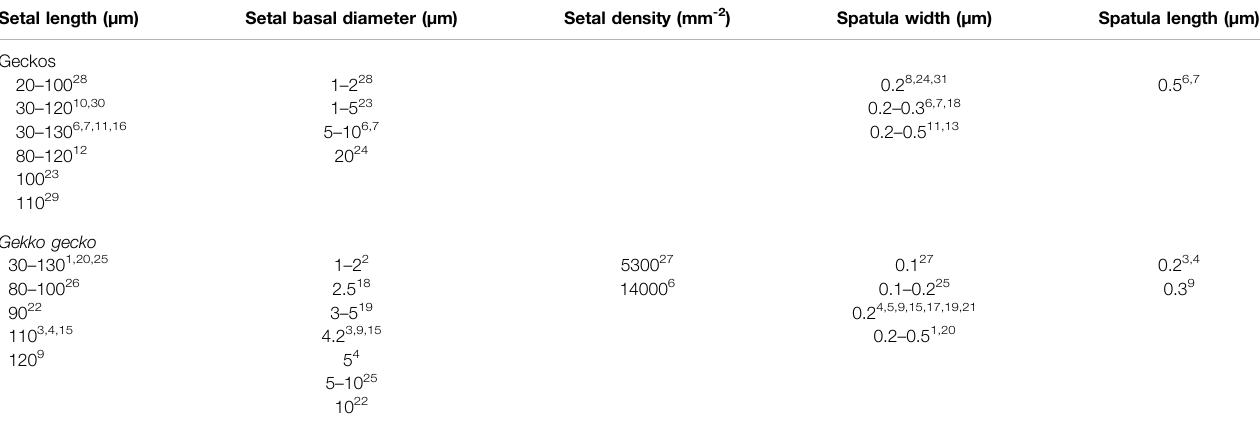
TABLE 1 | Data reported for setal dimensions for geckos in general and for Gekko gecko, indicating the variability in the values. For Gekko gecko , which has been used extensivelyinresearchfocusingongeckoadhesion, thevaluesreportedspanlargerangesbutgenerallyarenotaccompaniedbyinformationastowhereonthetoe pad the measurements were taken from. Apart from a few early investigations, most of the values reported are taken from papers published between 2005 and